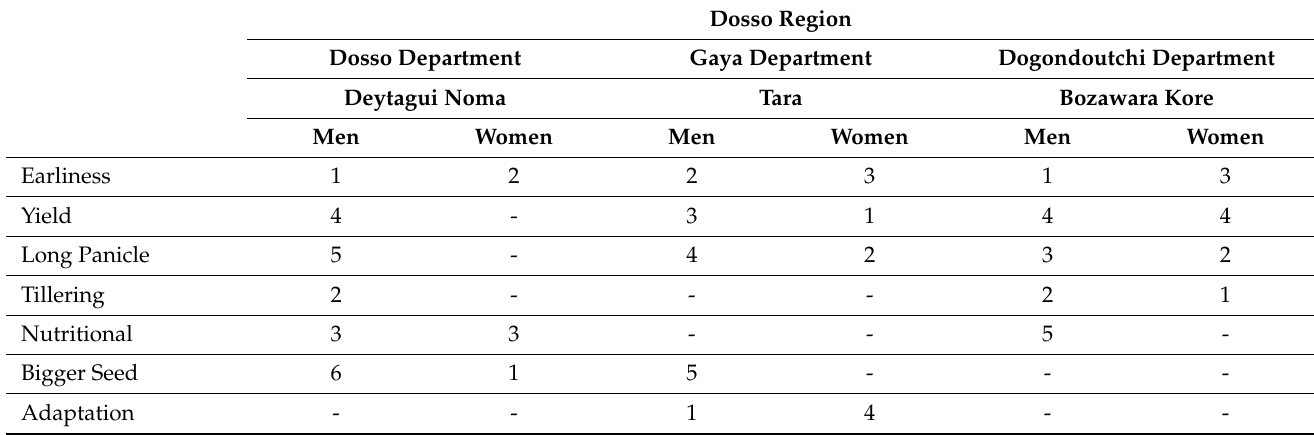
Table 3. Farmers’ pearl millet trait preferences ranked according to importance in three departments (Dogondoutchi, Dosso, and Gaya) of the Dosso region in Niger.